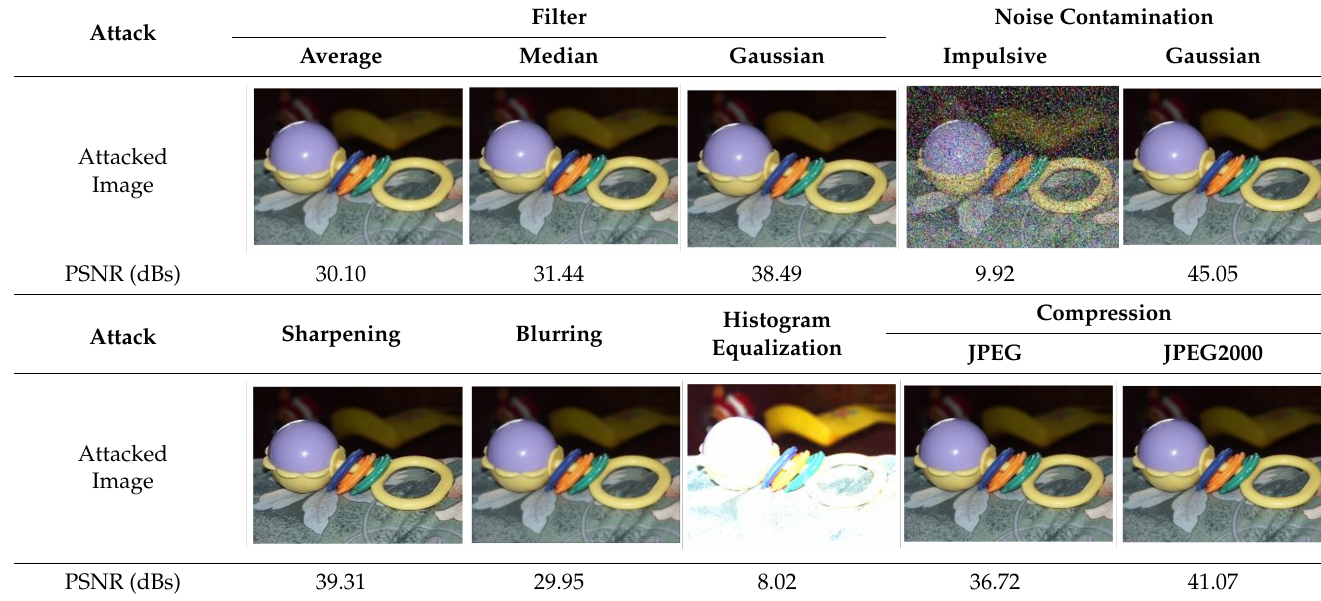
Table 7. QR watermarked image after image processing